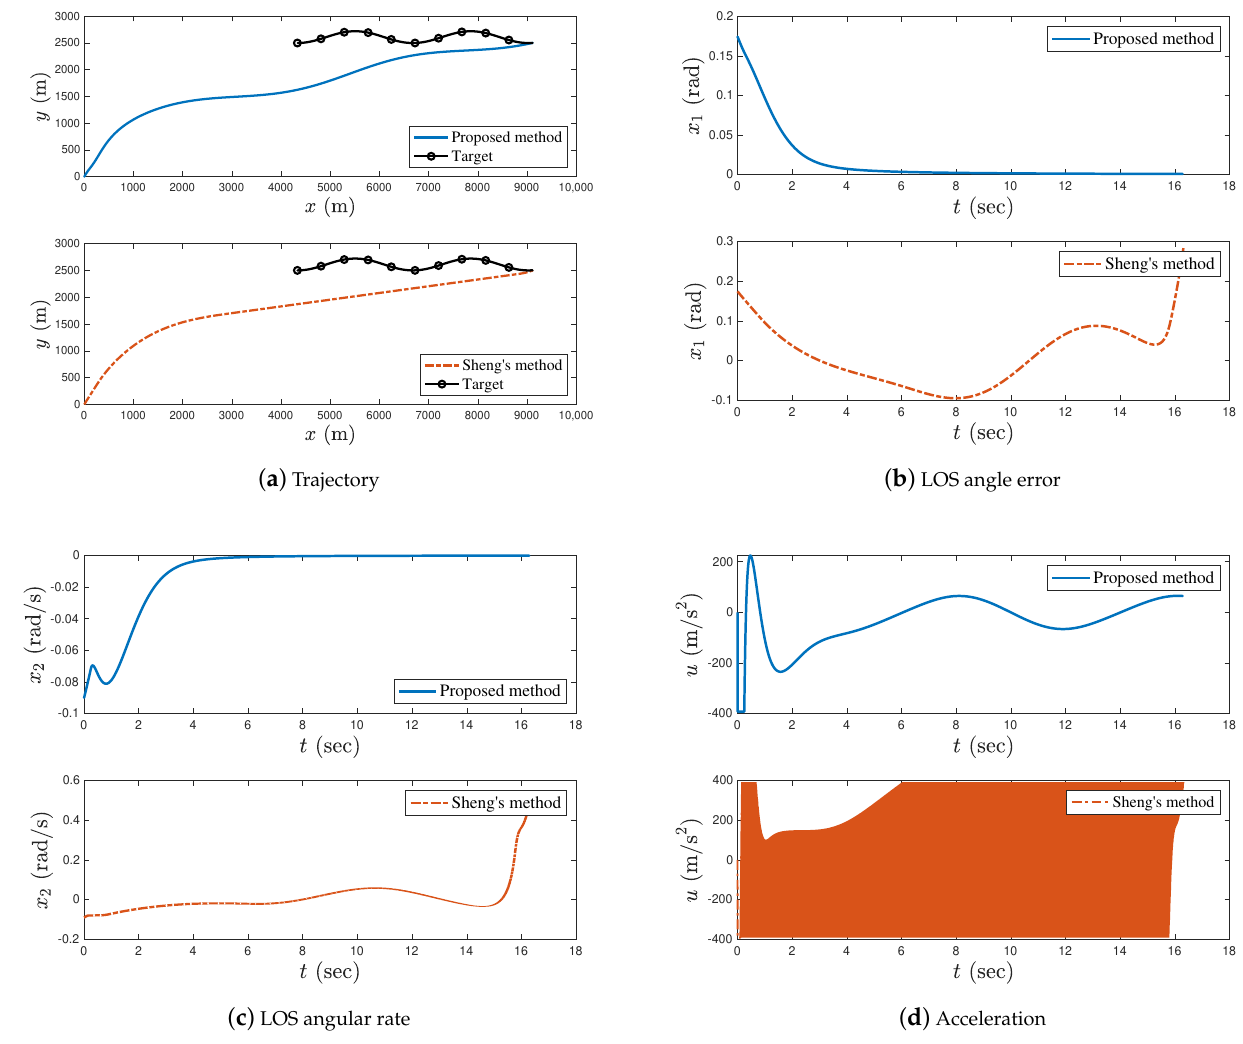
Figure 13. Comparison of the proposed method and the method in Ref. [15] with α = 0.07. The next set of simulations for the guidance laws based on the integer-order linear sliding mode (LSM) [39], terminal sliding mode (TSM) [39], and nonsingular fast terminal sliding mode (NFTSM) [39] are shown for the comparison with the presented guidance law in this paper. All parameters of the LSM, TSM, and NFTSM guidance laws are the same as those chosen in the presented guidance law. The initial conditions of the missile and the target, the terminal LOS angle, and the target acceleration are the same as those of the previous simulation in this subsection. The fractional order of the proposed guidance law is set to 0.03. The trajectories of the missile and the target, the LOS angle, the LOS angular rate, and the missile acceleration for the four guidance laws are shown in Figure